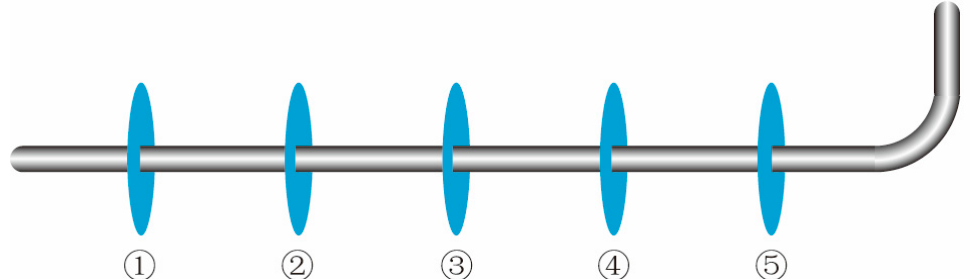
Figure 8. Perforation distribution.